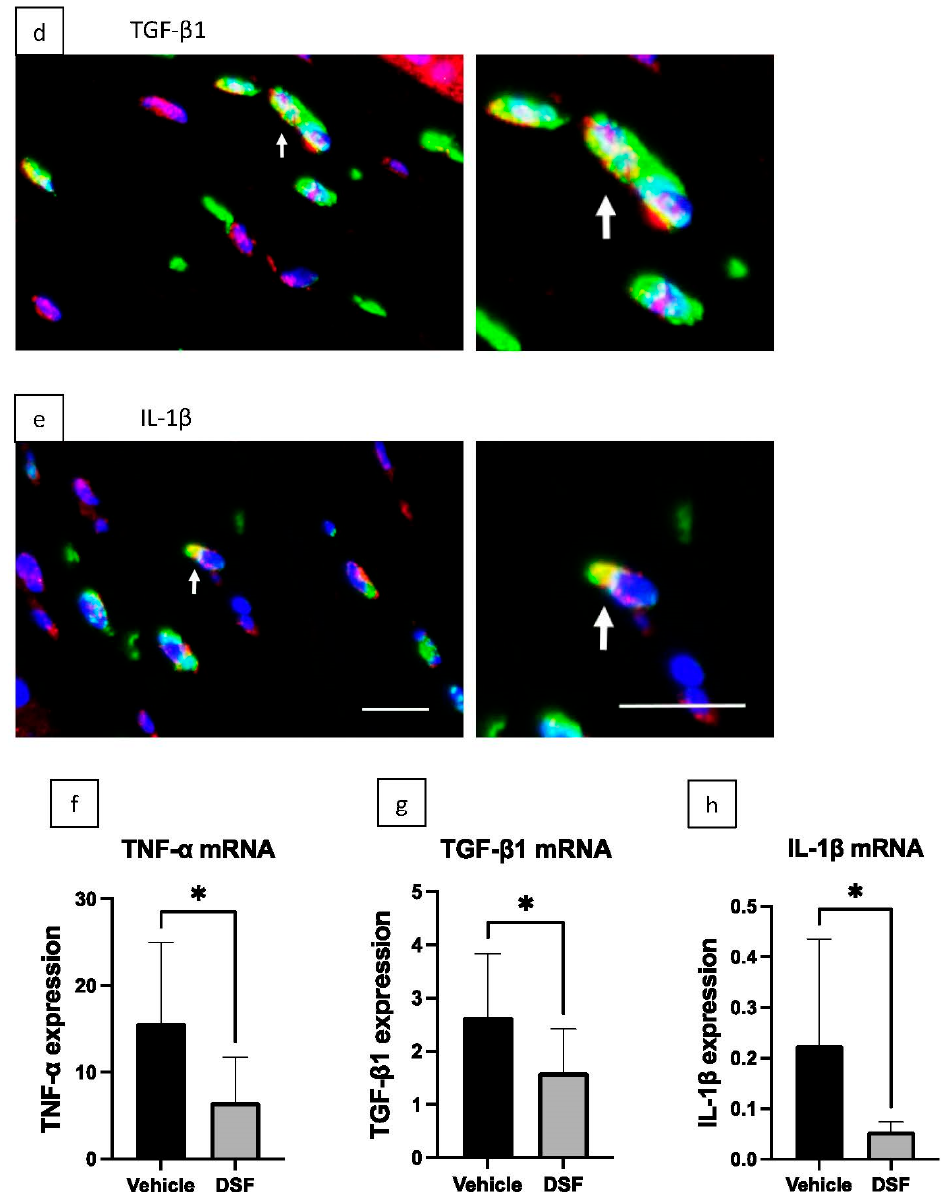
Figure 4. Fluorescence immunostaining was performed to determine the presence of FROUNT-related molecules and macrophage-associated cytokines on ED-1-positive cells infiltrated in a corneal alkali burn model. Fluorescence immunostaining was performed in the Vehicle group 1 day after alkali burn. Blue-stained cell nuclei with DAPI, green-stained ED-1, and red-stained target molecules, respectively, were evaluated. Areas that are positive for both ED-1 and the target molecule appear to be stained yellow. FROUNT was present on ED-1-positive cells ( a ). Phosphorylated AKT, a product of the FROUNT-induced PI3K pathway, was present on ED-1-positive cells ( b ). TNF- α , TGF- β 1, IL-1 β were also present on ED-1-positive cells ( c – e ). RT-PCR was performed on corneas 4 days after alkali burn, and macrophage-related cytokines of the DSF and Vehicle groups were compared. The results showed that TNF- α , TGF- β 1, and IL-1 β were significantly downregulated in the DSF group ( f – h ). Bar, 10 μ m. White arrows indicate cells double positive for ED-1 and target molecules (yellow staining). Data are presented as mean ± standard error ( n = 8 samples/group). * p < 0.05.